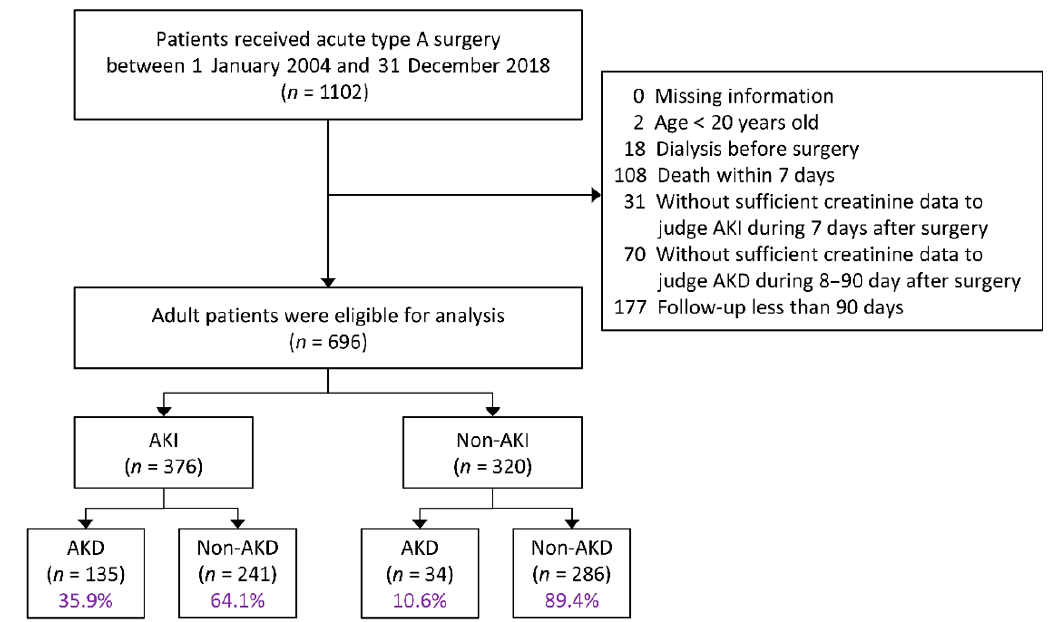
Figure 1. Diagram of patient selection. AKI, acute kidney injury; AKD, acute kidney disease.